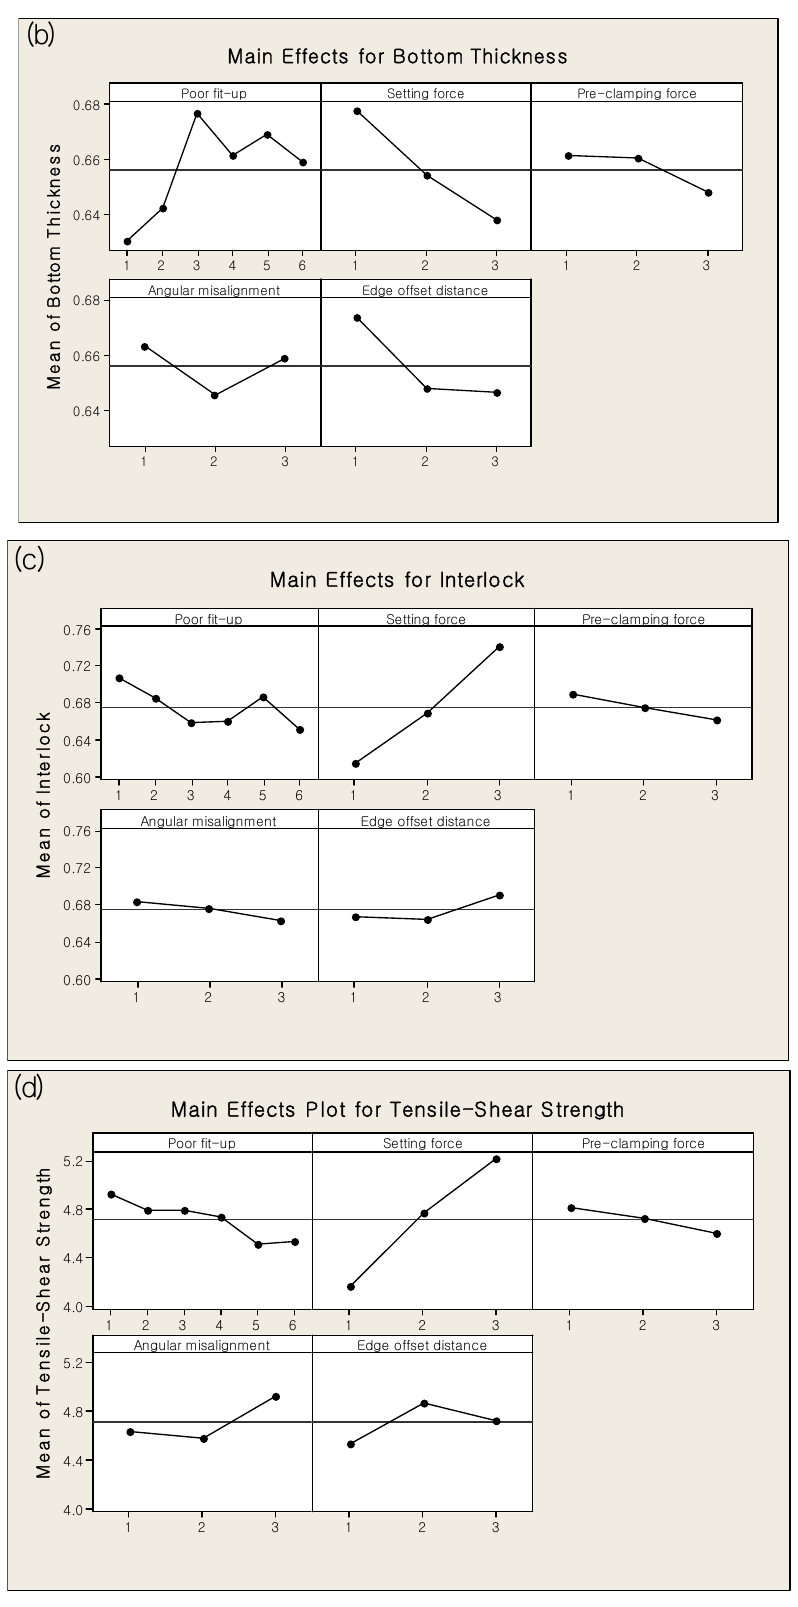
Figure 5. Main effects for control parameters. ( a ) Head height; ( b ) bottom thickness; ( c ) interlock; ( d ) tensile-shear strength.